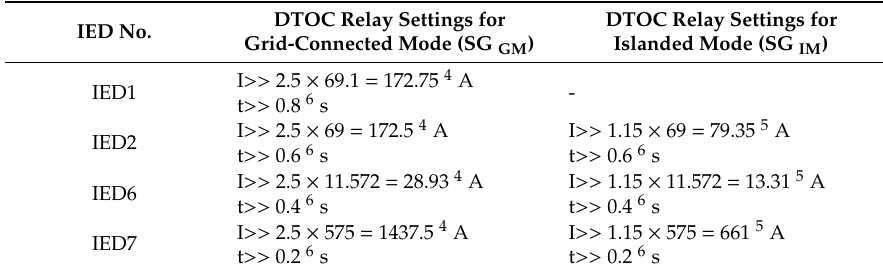
Table 4. Settings of overcurrent IEDs for grid-connected and islanded modes as per DG scenarios 1–4 in Table 2 considering the max normal magnitude of current through IEDs in these scenarios.